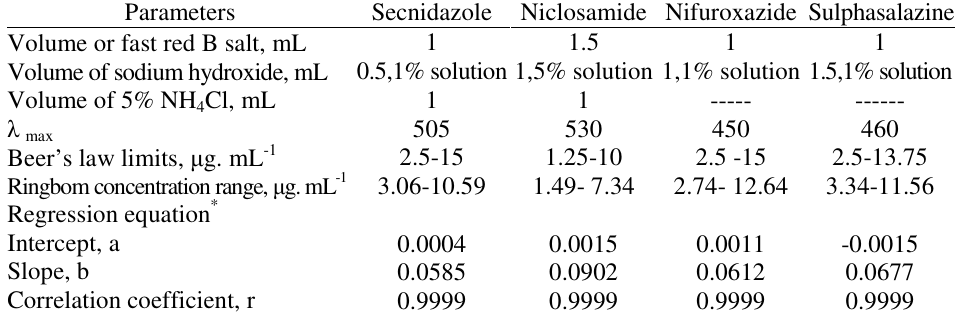
Table 1. Analytical parameters for the determination of the cited drugs using fast red B salt